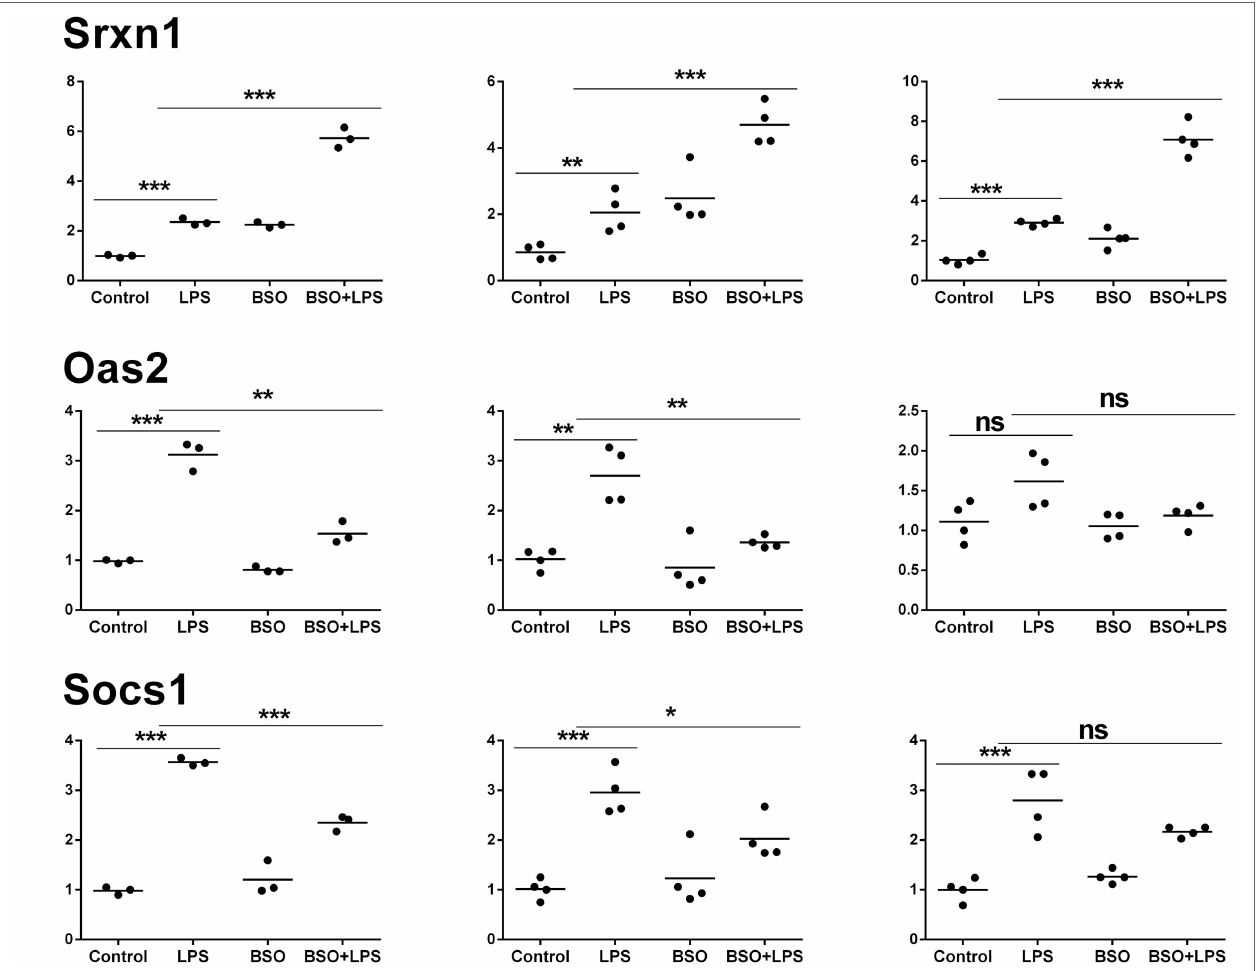
FigUre 6 | PCR validation of the microarray data at 2 h. Results for seven genes (il1b, Irf9, Mx2, Il4i1, Srxn1, Oas2, Socs1), comparing expression data from microarrays ( N = 3 biological replicates; left graphs) with results from PCR analysis using all the four replicates of the RNA from the same experiment ( N = 4 biological replicates; middle graphs) and RNA from an independent experiment ( N = 4 biological replicates; right graphs). Data are expressed as fold change vs one of the respective control samples. For each experimental group, the mean is also shown. * P < 0.05, ** P < 0.01, and *** P < 0.001 by two-tailed Student’s t -test. PCR, polymerase chain